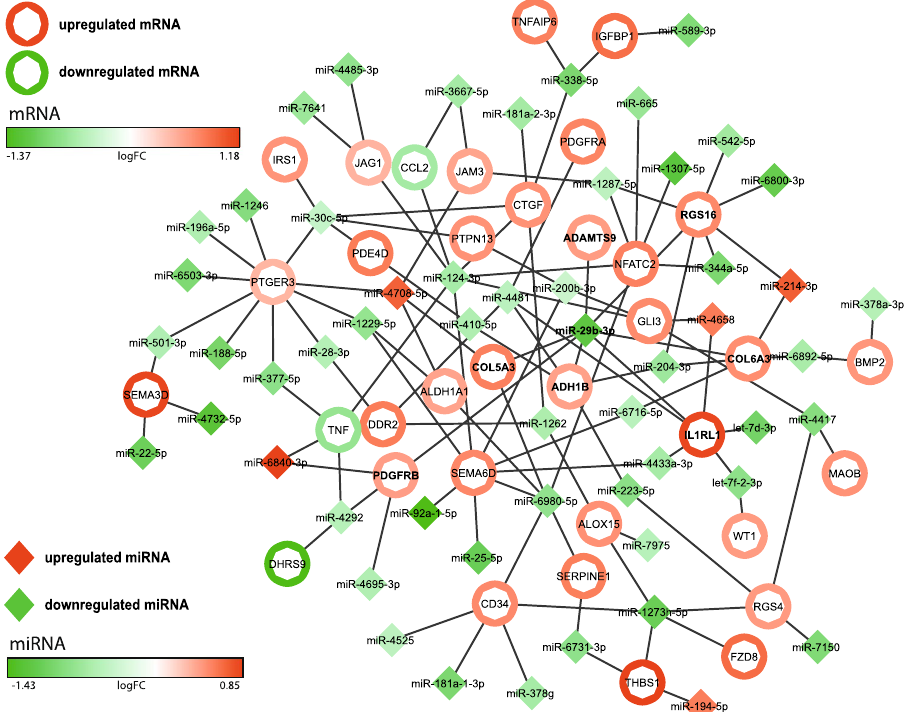
Figure 6. Analysis of miRNA-mRNA interaction in peritoneal effluent cells. Interaction network of differentially abundant miRNAs (solid diamonds) and differentially abundant mRNAs (unfilled circles) present in significantly enriched pathways. The top candidate miR-29b-3p (bold in center) is down-regulated and links to 7 up-regulated genes (bold). Table 4 presents a rank list of interactions, based on number of observed and concordantly regulated target